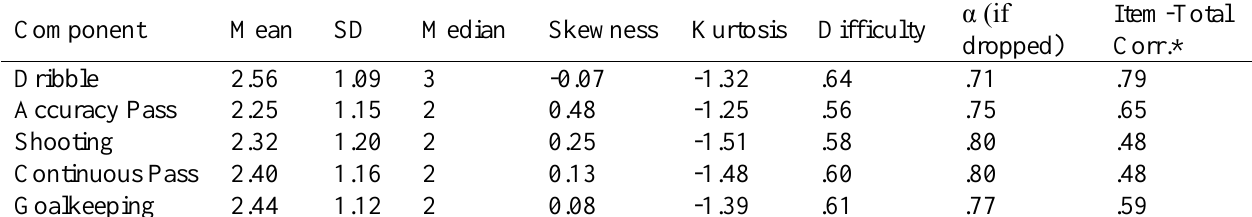
Table 3. BFST-AVI quartile score statistics.